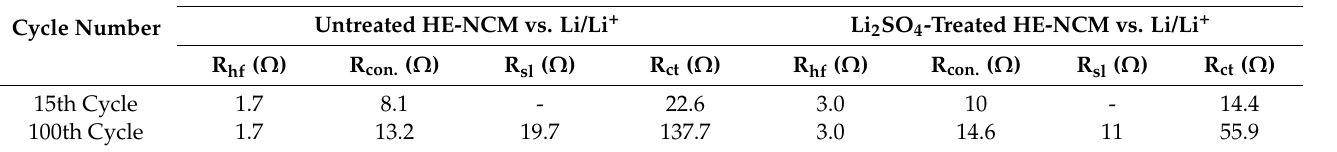
Table 2. Fitted data for impedance spectra measured from HE-NCM electrodes at 15th and 100th cycles at an equilibrium potential of 4.0 V during discharge. The corresponding impedance spectra of these cells are presented in Figure 10. In this table, R hf , R con , R sl , and R ct relate, respectively, to the solution resistance measured at high frequencies, the contact resistance of the cathode, the resistance of the Li + migration through the surface layer formed on the cathode, and interfacial charge-transfer resistance, representing a contribution from both the electrodes (cathode and anode) in Li cells. Electrochemical Cell Configuration Untreated HE-NCM vs. Li/Li + Li 2 SO 4 -Treated HE-NCM vs. Li/Li